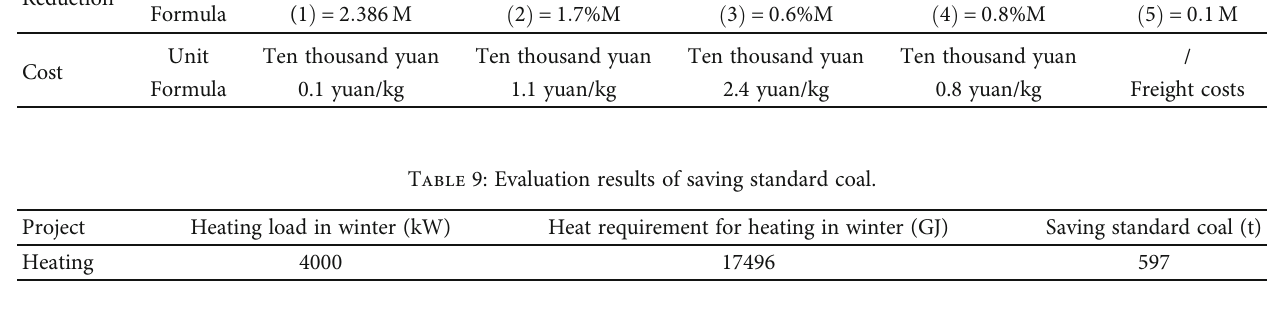
Table 10: Evaluation results of emission reduction and cost-saving.